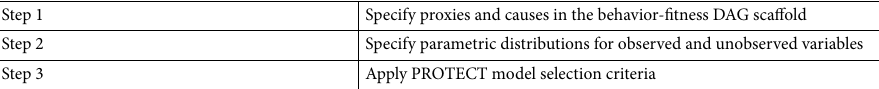
Table 2. Overview of the PROTECT method for developing individual treatment effect models from observational cancer cohorts. Notes per step: 1. The causal Directed Acyclic Graph (DAG) describes the causal relationships between variables involved in the treatment decisions and outcomes. See Fig. 1 for the behavior- fitness DAG scaffold for observational cancer research. To apply PROTECT, researchers need to specify the definitions of treatment, potential additional proxies and causes of tumor behavior and patient fitness, and possibly the outcome. Potential additional application-specific sources of confounding or selection bias must be added as well. 2. These choices should be based on background knowledge. Specific care should be taken to check whether these distributions are uniquely identified. This depends on both the number of proxies of fitness (more is better) and the flexibility of the statistical models. 3. As multiple choices can be made in step 2, applying the PROTECT model selection criteria will reduce the dependence of treatment effect